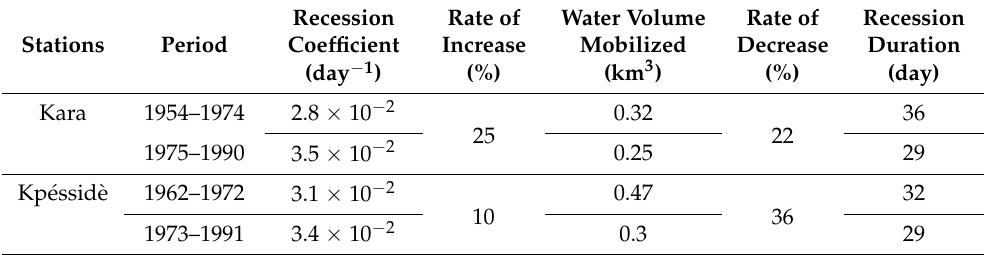
Table 5. Results of the calculation of the recession coefficients and the water volumes mobilized by the aquifers before and after the break dates.